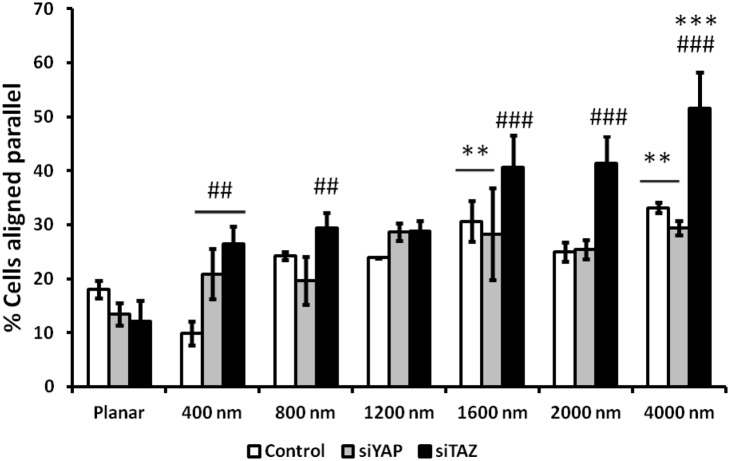
Downregulation of TAZ but not YAP mRNA expression increased cell alignment to topography.No statistical significance was observed in cell alignment between planar and 400 nm pitch surfaces for control siRNA group. Cell alignment was significantly upregulated after TAZ knockdown with the underlying ridges and grooves greater than 1600 nm with greatest number of cells aligned on 4000 nm pitch. Orientations of at least 200 cells per experiment per pitch were analyzed. Results were expressed as mean ± standard error of the mean of n = 3 individual experiments. Statistical comparisons were performed using Kruskal-Wallis pairwise multiple comparison, **p<0.01, ***p<0.001 compared with planar, ##p<0.01, ###p<0.001 compared with control non-targeted siRNA.